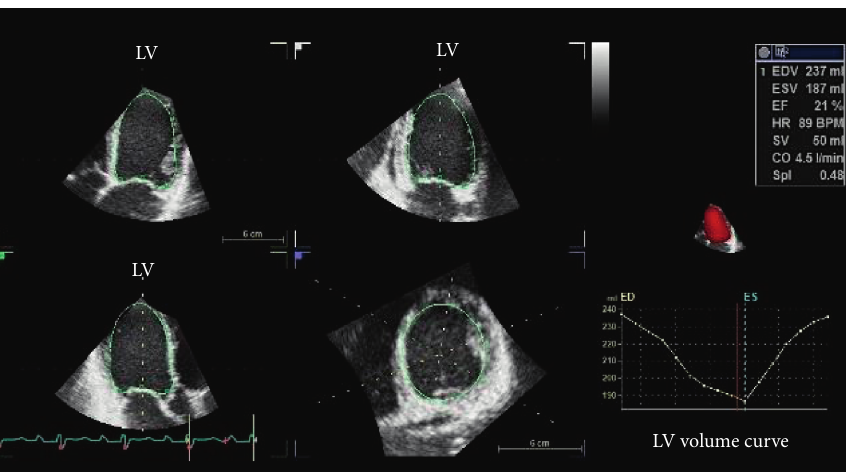
Figure 1: Left ventricular quantitative analysis using 3D transthoracic echocardiography in a patient with dilated cardiomyopathy and functional mitral regurgitation. LV: left ventricle.